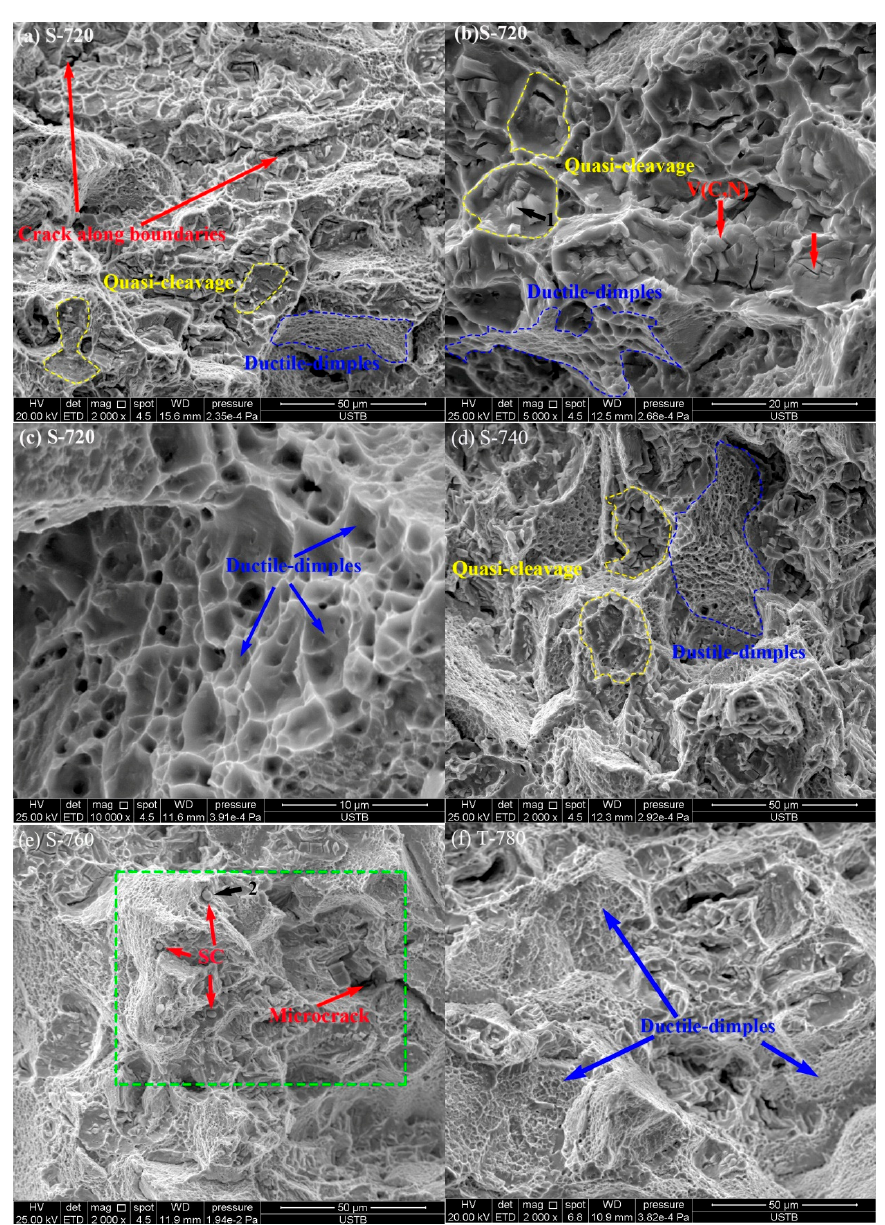
Figure 13. SEM fractographs of specimens after different aging heat treatment processes: ( a–c ) S-720; ( d ) S-740; ( e ) S-760; ( f ) T-780. ( b ) and ( c ) are highly magnified images taken at the region enriched with quasi-cleavage facets and dimples of specimen S-720, respectively. SC represents secondary